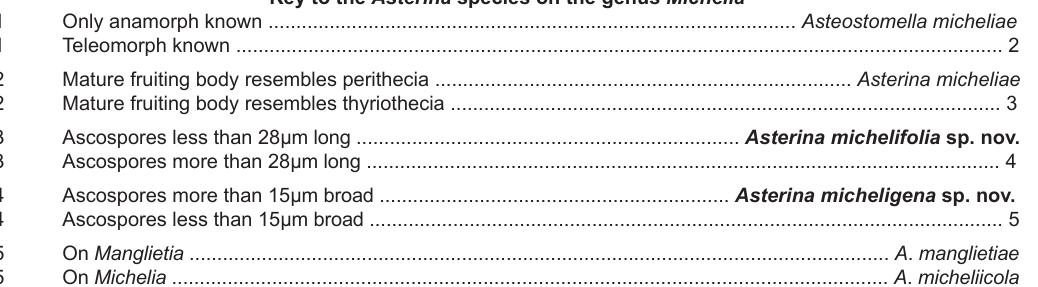
smooth. Etymology: Specific epithet based on the host